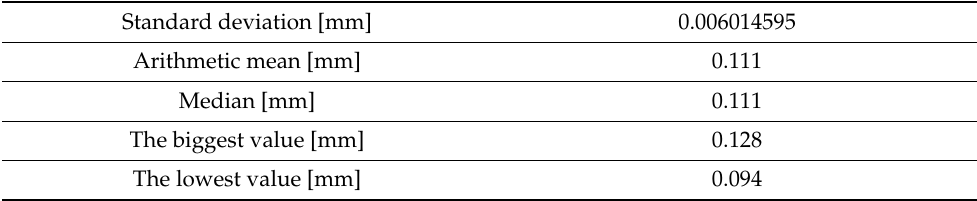
Figure 11. Constructed histogram based on measured values shows the constructed histogram and in Table 2 the meas- ured quantities are given. quantities are given. Table 2. Processed and evaluated measured quantities. Table 2. Processed and evaluated measured